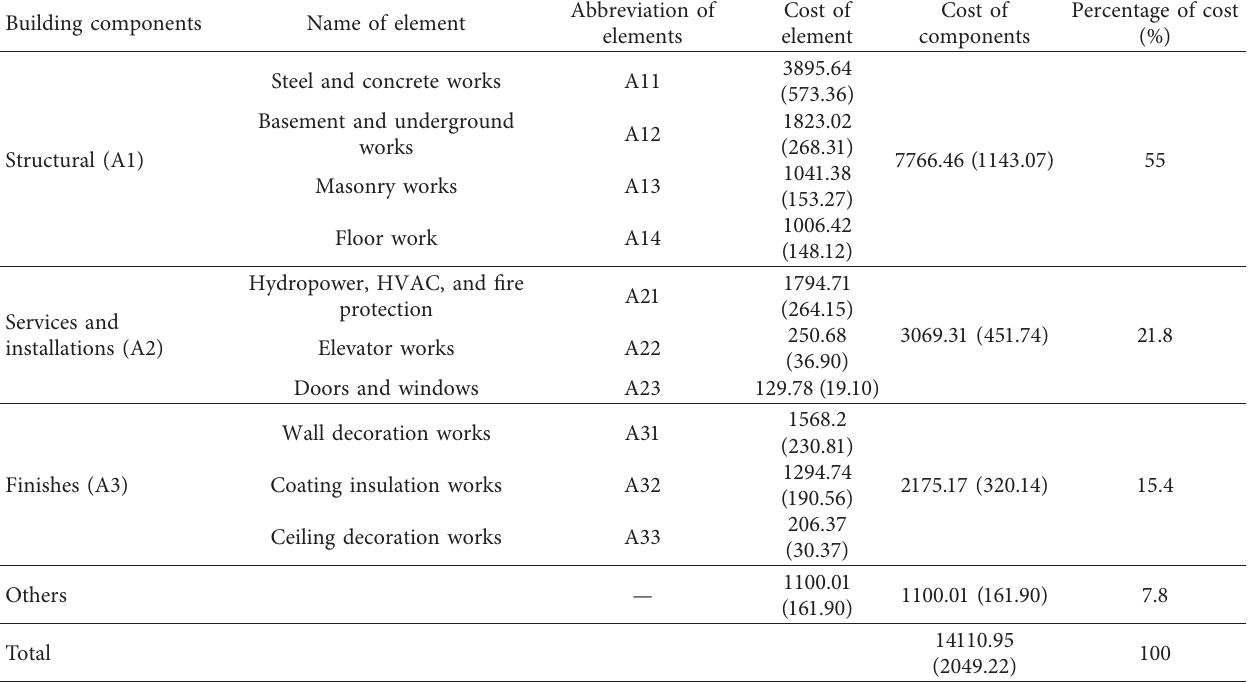
Table 3: Cost of components and elements of the CJ building in ten thousand RMB (USD).